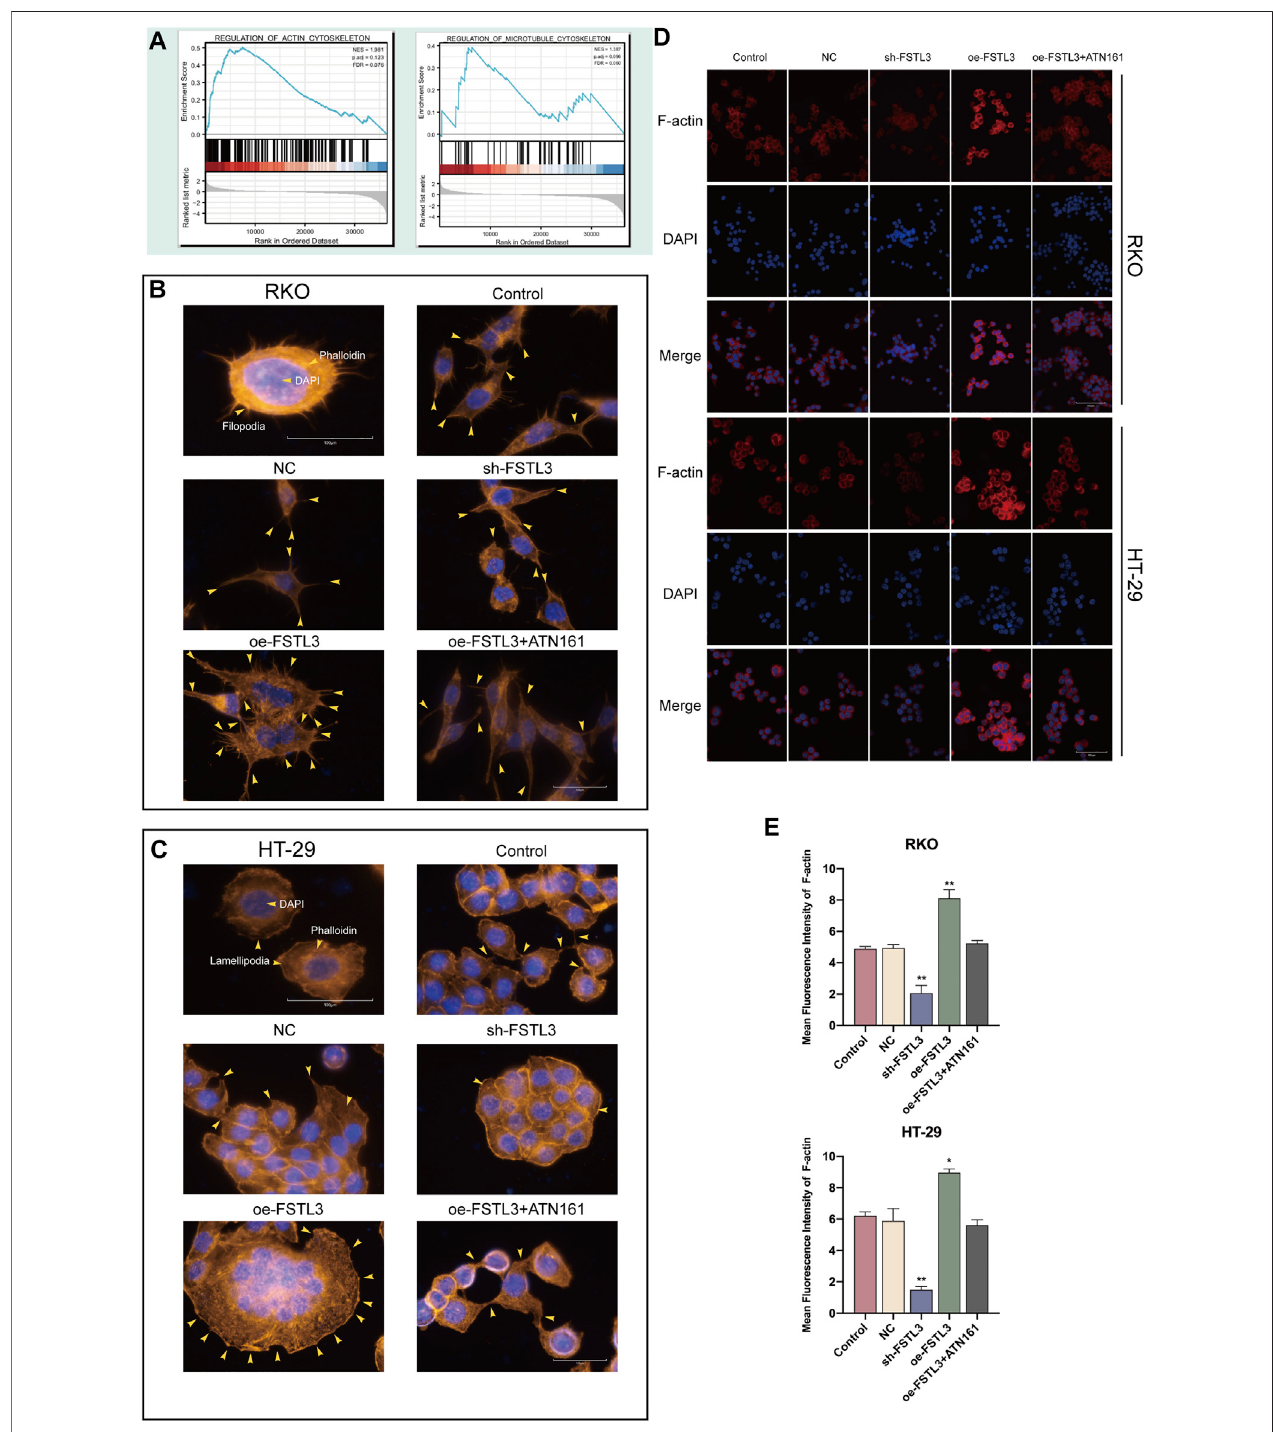
FIGURE 5 | Relationship between the FSTL3 and the F-actin cytoskeleton. (A) Gene Set Enrichment Analysis (GSEA) of FSTL3 . (B – D) The cytoskeleton of colorectal cancer (CRC) cells (control cells and CRC cells transfected with the NC, sh- FSTL3 , and oe- FSTL3 constructs) treated with 5 μ M ATN-161 detected using phalloidin staining and immuno fl uorescence staining. [ (B) : RKO, (C) : HT-29] Yellow arrowheads point to fi lopodia/larger lamellipodia/pseudopodia-like protrusions. (E) Immuno fl uorescence intensities expressed as mean intensity ± SD. * p < 0.05, ** p < 0.01, *** p < 0.001. Arrowheads indicate pseudopodia.